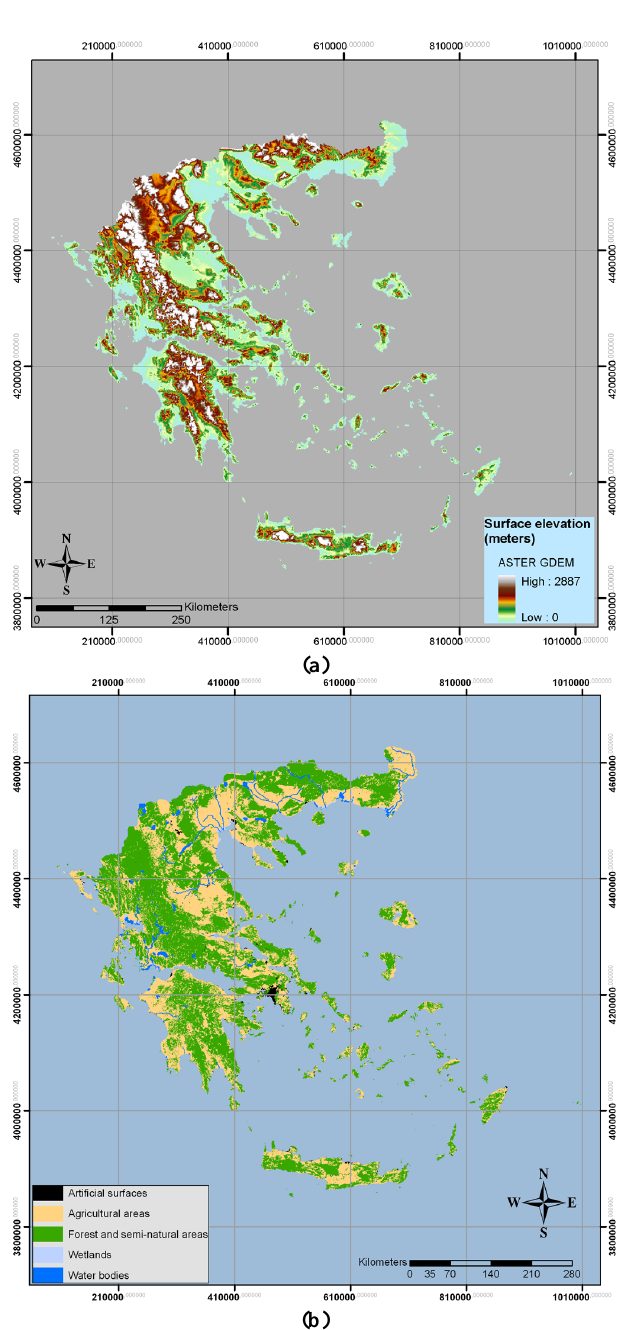
Fig. 3. The digital elevation model of Greece derived from the ASTER GDEM ( a , above) as well as the CORINE 2000 ( b , below) used in our analysis after the pre-processing